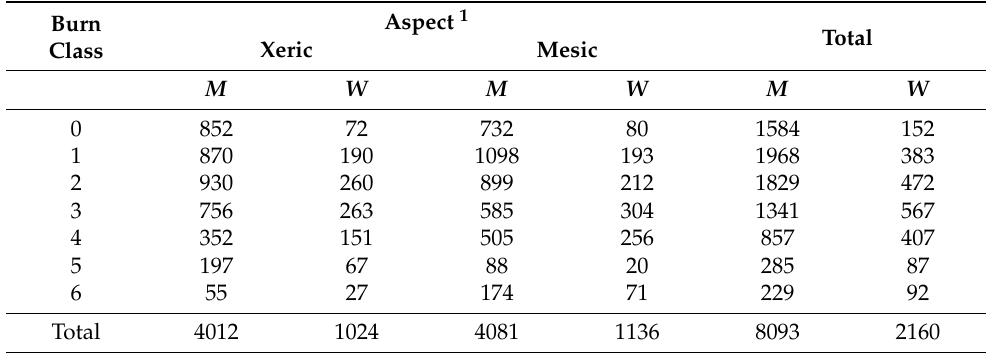
Table 2. Distribution of measured ( M ) and wounded ( W ) trees by aspect and burn class.